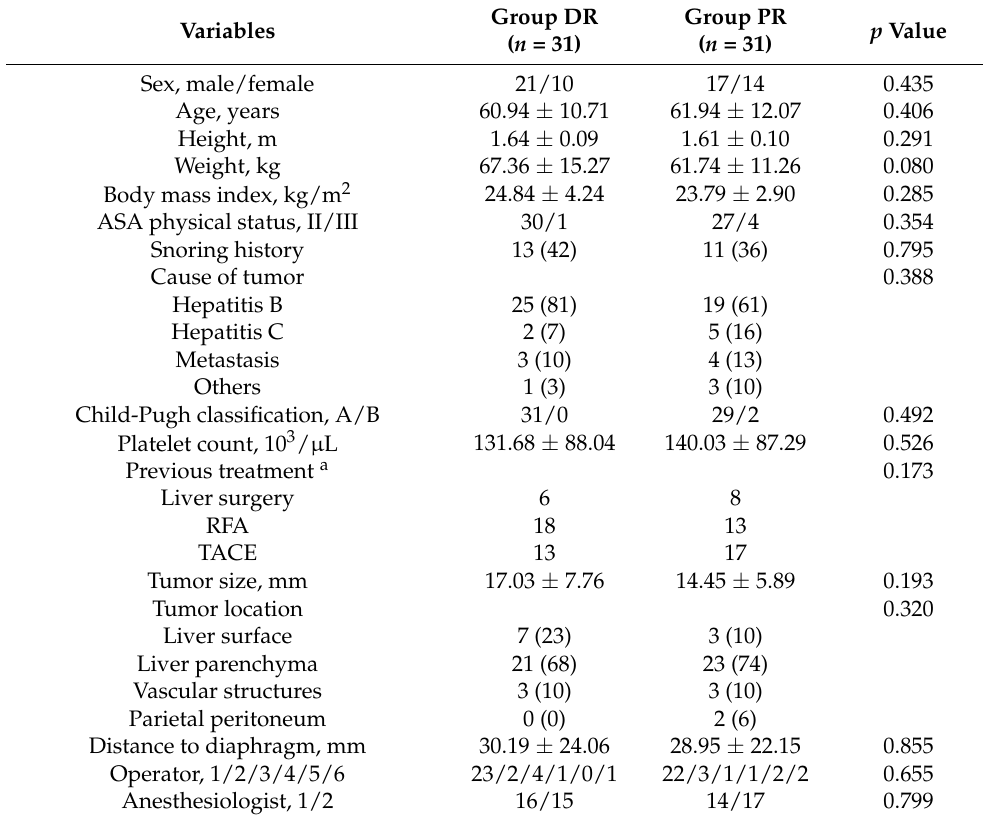
Table 1. Characteristics of patients and operative data.